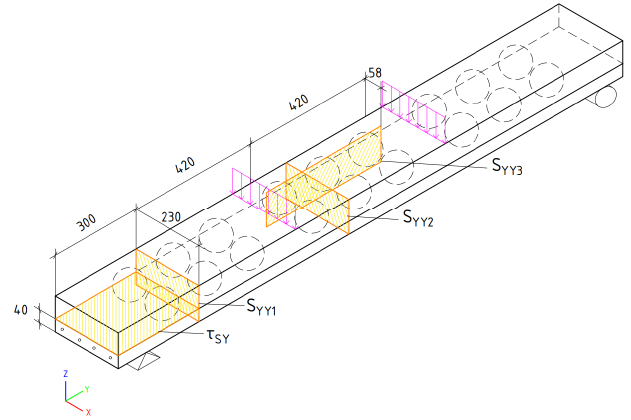
Figure 10. The sections for stress distribution analysis.